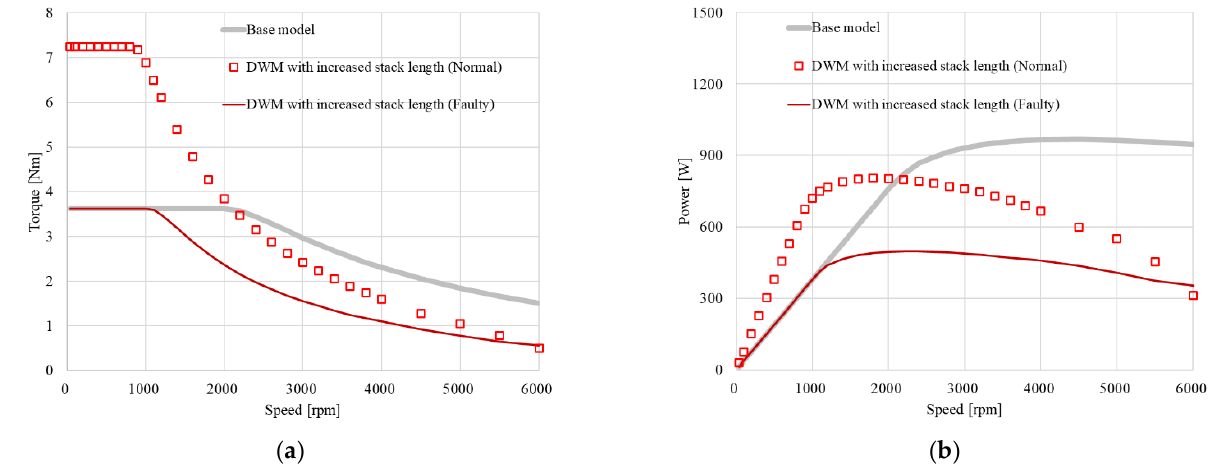
Figure 9. Comparison of torque and power characteristics between the base model and the DWM with an increased stack length: ( a ) Torque; ( b ) Power.